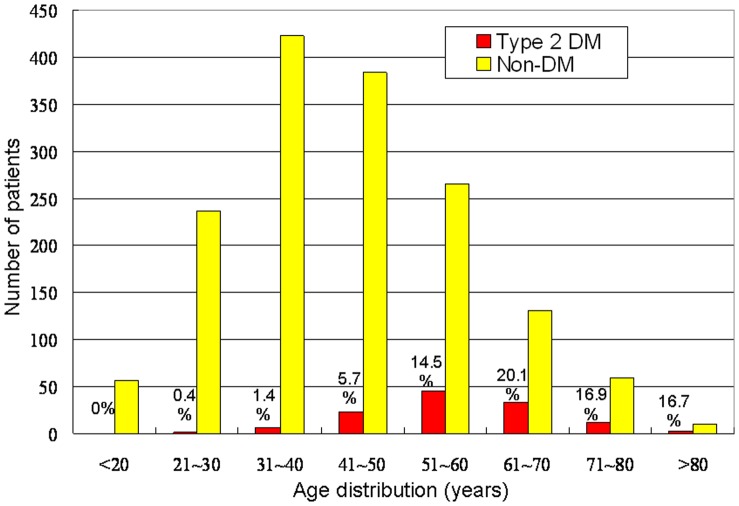
Age distribution of the subjects.Age distribution and number of thyroid cancer patients were demonstrated with and without type 2 diabetes mellitus (DM). The percentages of type 2 DM were presented in each age group.